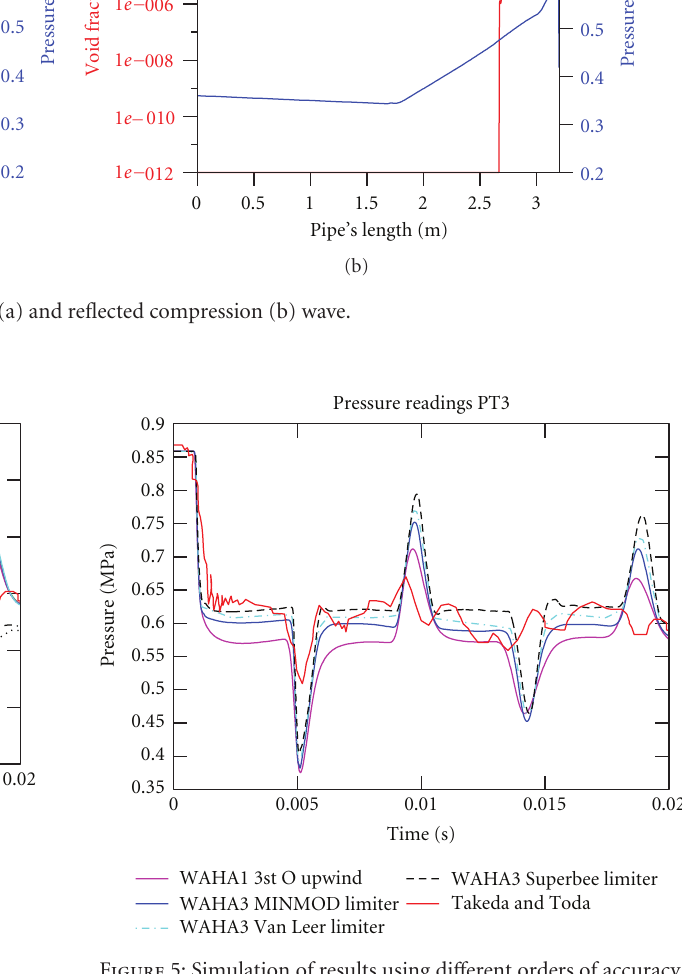
Figure 4: Comparison between WAHA, RELAP5 and experimental results for di ff erent Courant numbers.